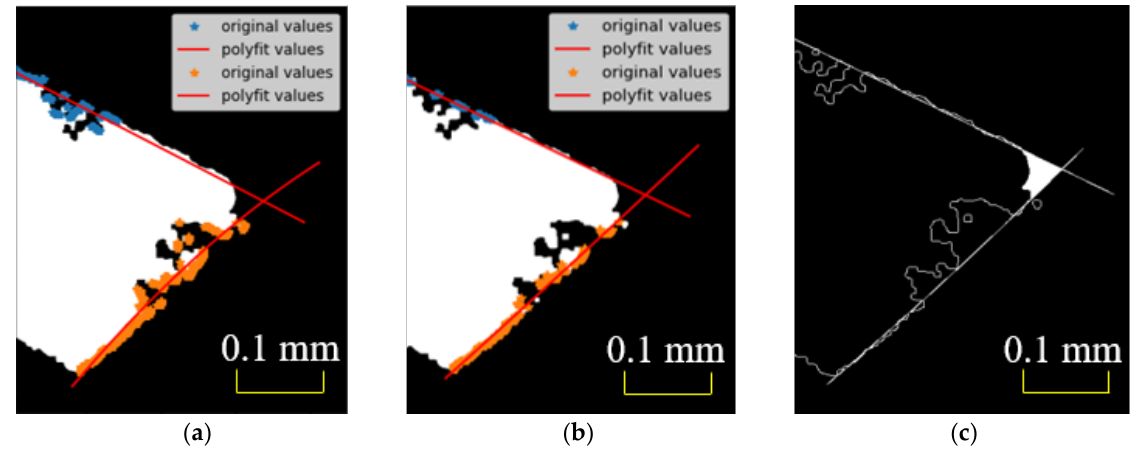
Figure 11. Edge fitting reconstruction process. ( a ) Right edge fitting; ( b ) Curve fitting after eliminating the error points; ( c ) The breakage.